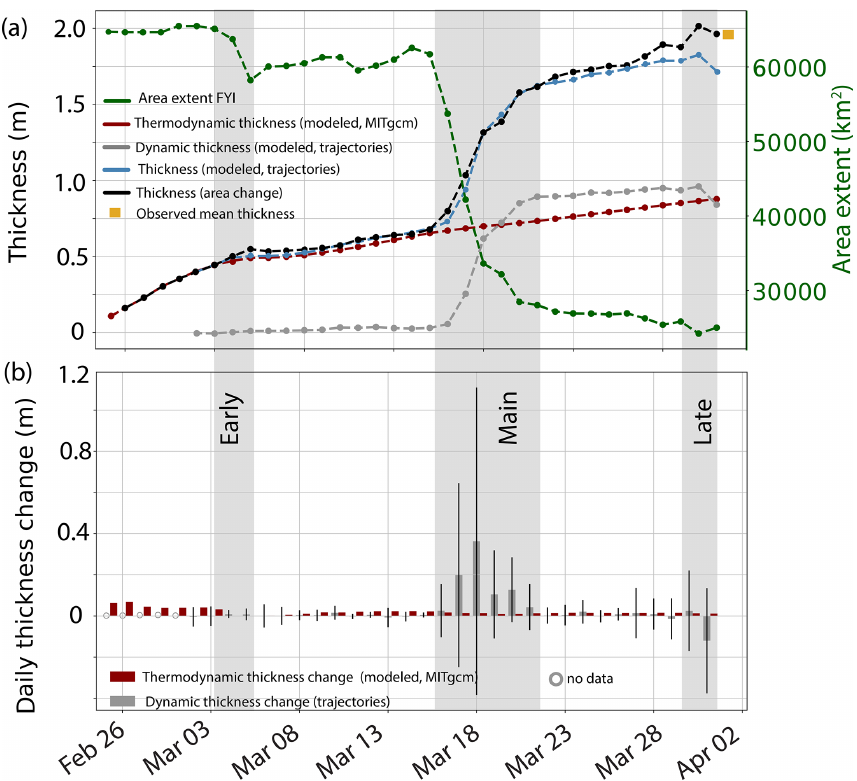
Figure 4. Dynamic and thermodynamic contributions to mean thickness from model and observations. (a) Time series of FYI area change (green, right y axis) derived from satellite images. The three deformation phases (early, main, late) are marked in gray. The thickness derived from the area change is shown in black (left axis). Accumulated mean thermodynamic (red, modeled, MITgcm) and dynamic (gray, simple volume-conserving model along trajectories) contribution to the thickness modeled from all trajectories (see b ) is displayed in blue. (b) Daily contributions from dynamics (simple volume-conserving model along trajectories) and thermodynamics (modeled, MITgcm) to the overall thickness. Error bars indicate the standard deviation of the dynamic contribution. The new ice that grew in the polynya was 0.38m thick by